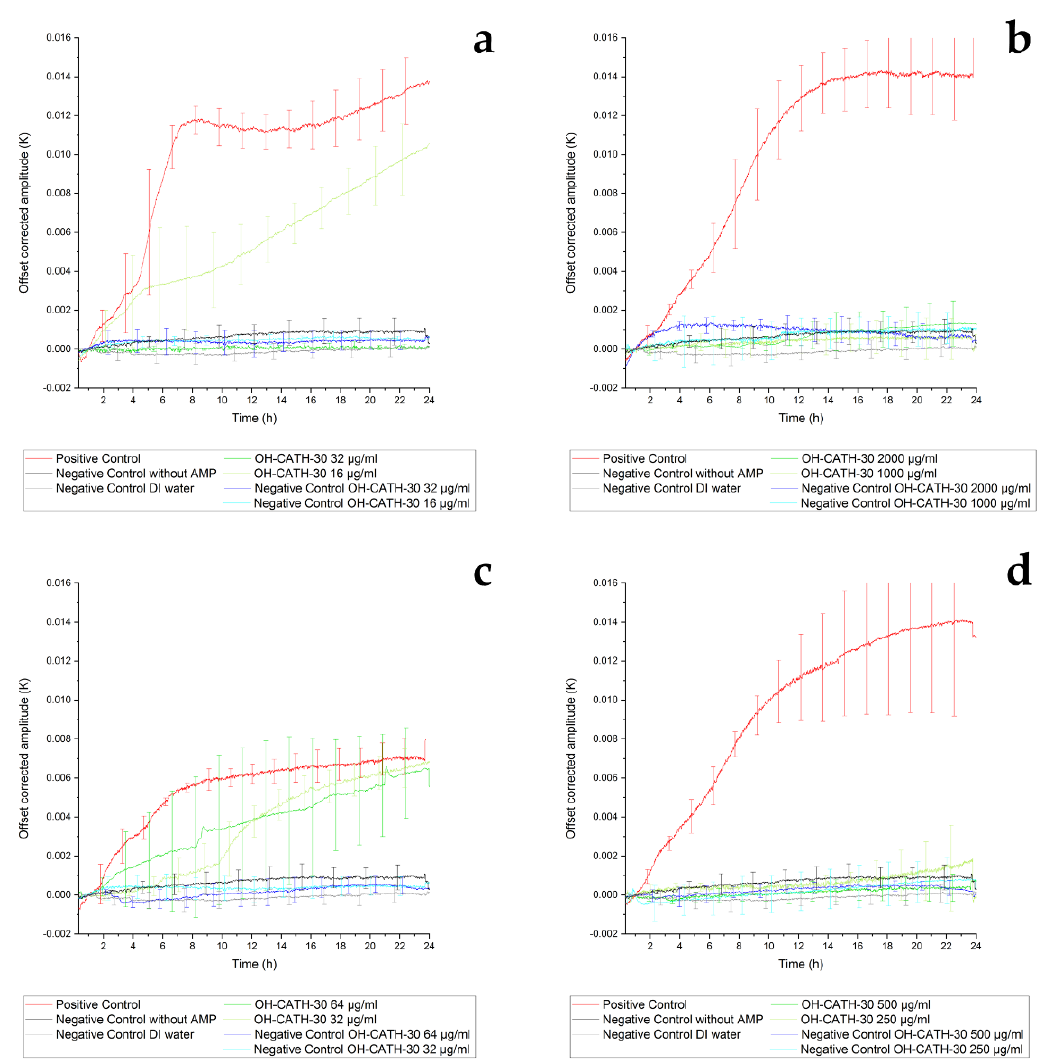
Figure 7. Representation of the thermal sensor measurement (at least n = 3). Different bacterial strains were incubated for 24 h at 37 ◦ C in a thermal sensor setup. The amplitude was measured every second and filtered by a low-pass filter integrated in a lock-in amplifier. The offset was corrected by setting the zero point at 1 h. For clarity, the error bars are staggered. The displayed results were averaged from at least three experiments and the standard deviation is shown as well. The used strains were E. coli ATCC25922 ( a ) and IMT37453 ( c ) as well as S. aureus ATCC29213 ( b ) and IMT37556 ( d ). The strains were incubated in MH1 medium, either pure medium for positive control (red), with a high or a low dose of the AMP OH-CATH-30 (both green). The negative controls (purple and blue) were also conducted with either dose to exclude the effect of AMP precipitation, as well as pure MH1 medium (black) and DI water (gray) to exclude the effect of precipitation of